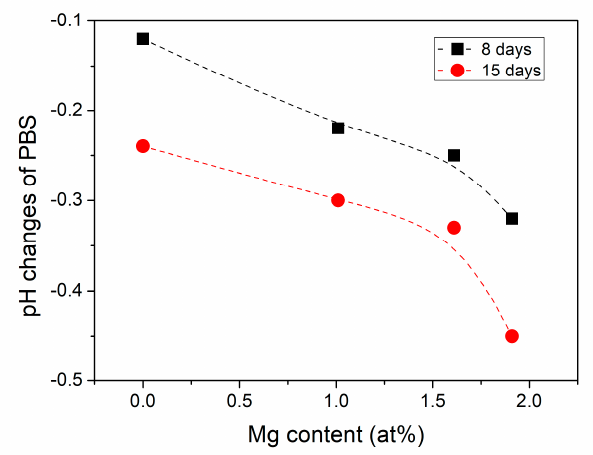
Figure 7. The difference in pH of the PBS after 8 and 15 days of glasses immersion as a function of Mg content. The difference was calculated as pH of the PBS after incubation of glass—pH of the PBS before incubation.